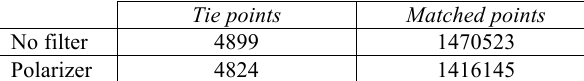
Table 3. Metallic object #2 (Umbo). Matching results with and without polarizing filter.